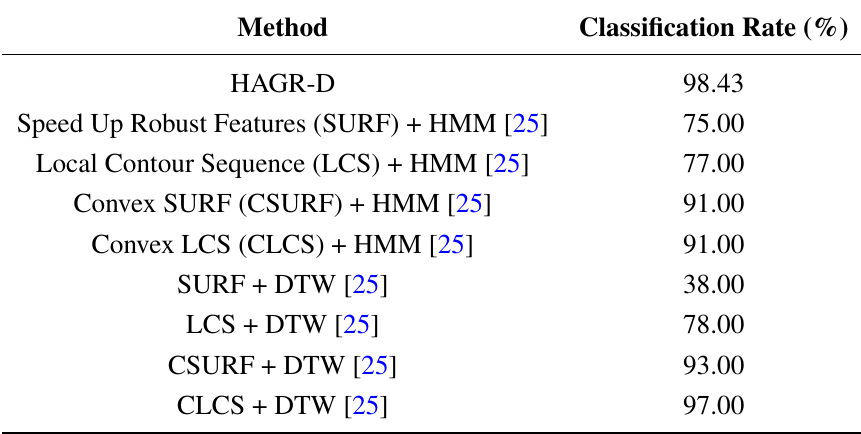
Table 6. Comparison between the results in RPPDI dynamic gesture